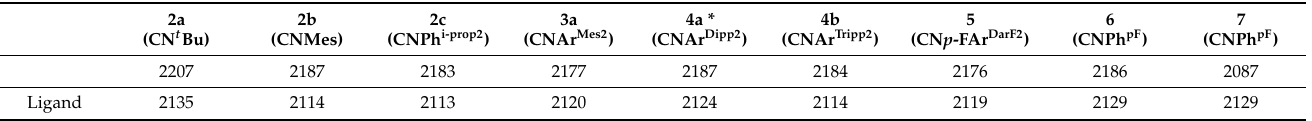
Table 3. ν CN Frequencies in the complexes under study compared with the values in the uncoordi- nated